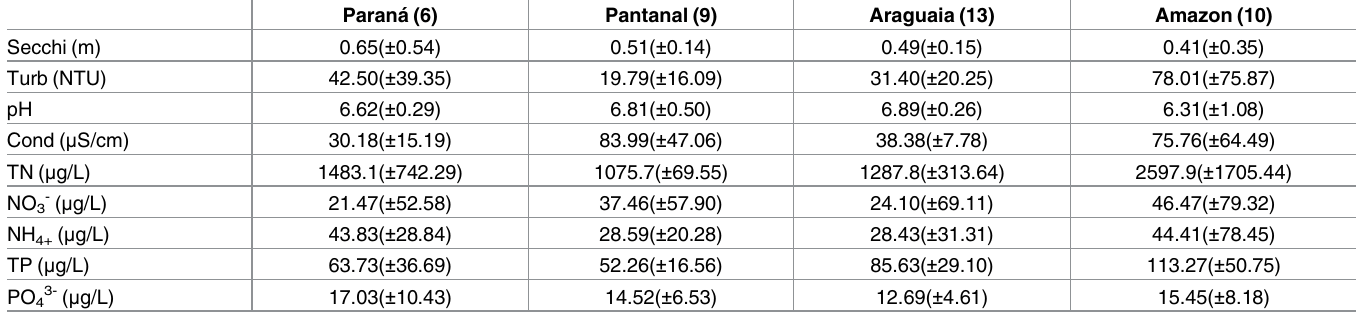
Table 1. Mean ( ± standarddeviation) of limnological parameters for each basin. TN = Total Nitrogen;TP = Total Phosphorous;Turb = Turbidity; Cond = Conductivity. The number of sample sites for each basin are in